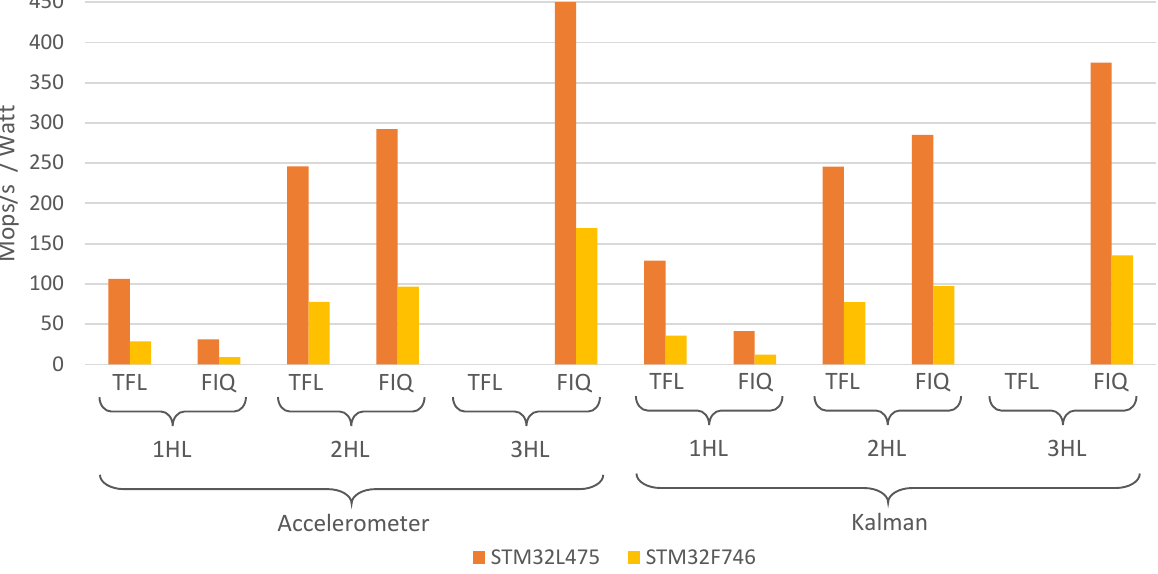
Figure 6. Mops/s per Watt for each of the studied models and hardware